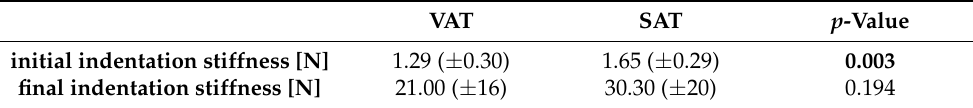
Table 1. Initial indentation stiffness and final indentation stiffness for VAT and SAT specimens. VAT SAT p